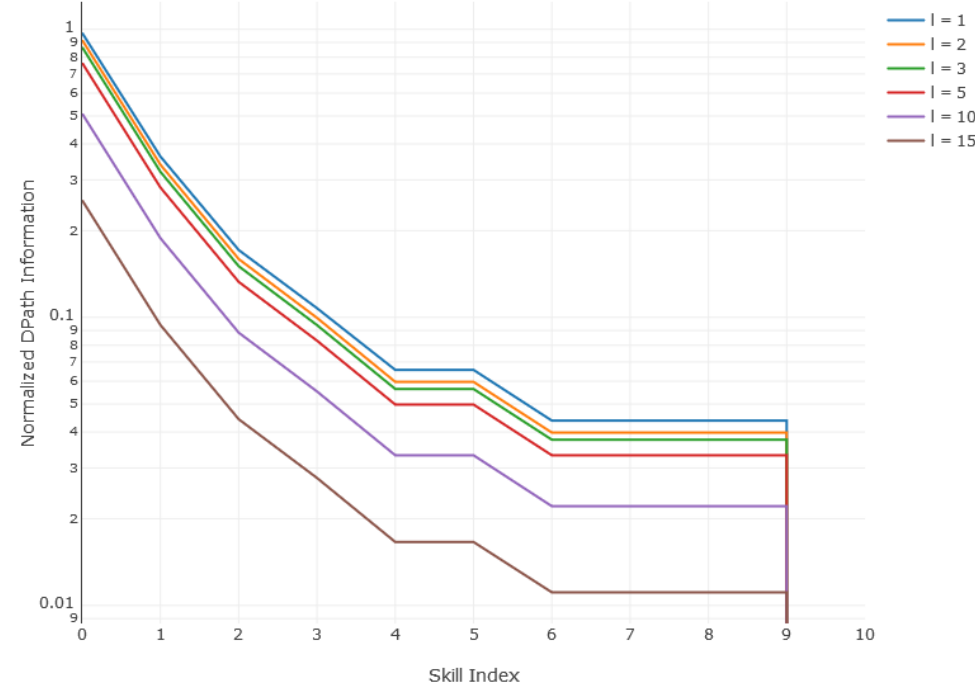
Figure 8. Normalized DPath Information vs. Skill Index by composition index, l